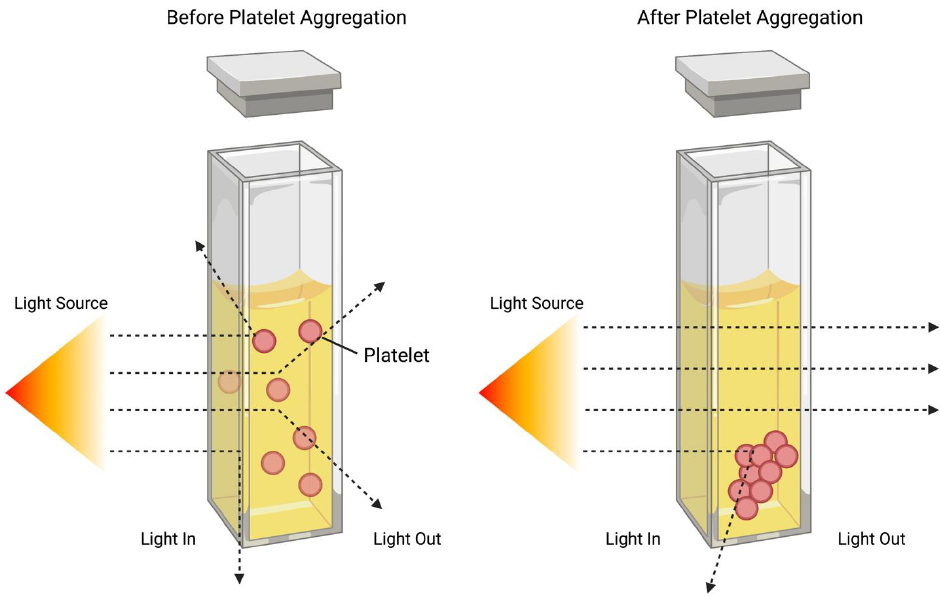
Figure 3. Comparing light transmission before and after platelet aggregation using light transmission aggregometry. Light rays from the light source are represented with the dotted line.